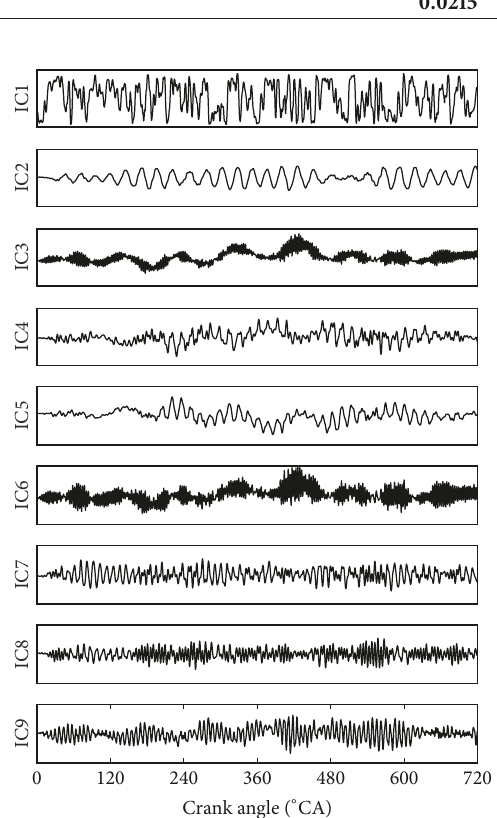
Figure 13: RobustICA calculation